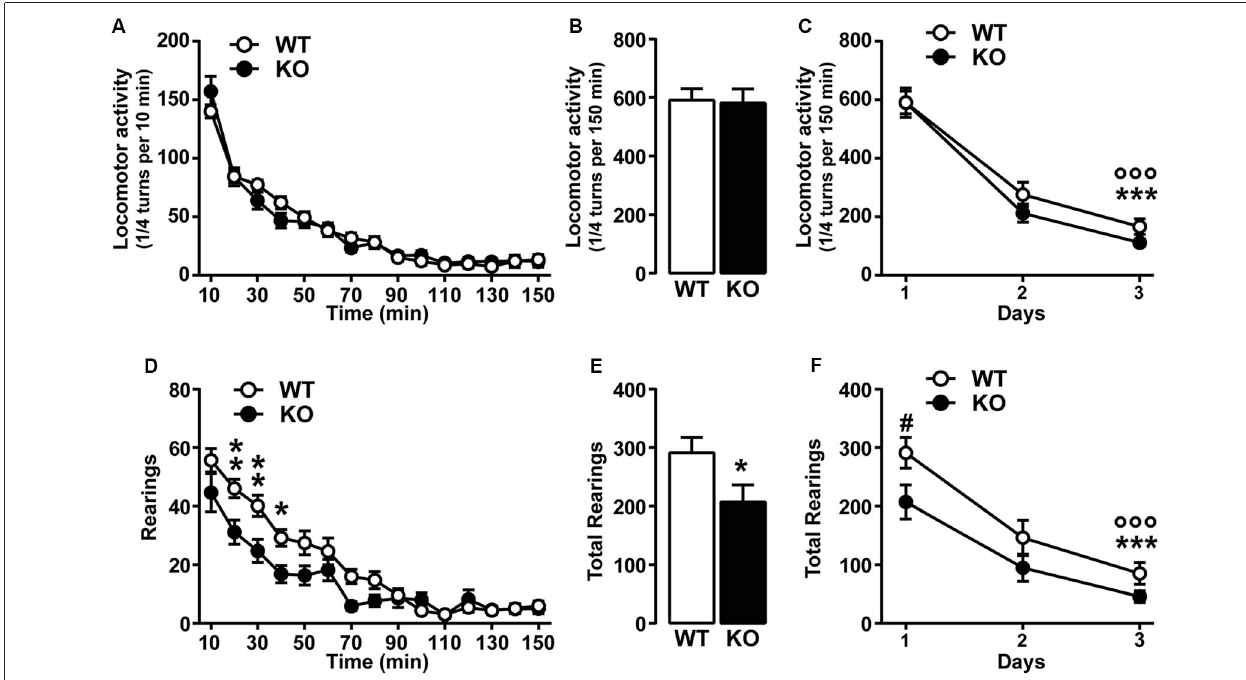
(vertical locomotor activity) of Ca v 3.2 null mice ( n = 22) and their WT littermates ( n = 26) in a novel non-stressful environment. Data (means ± SEM) were analyzed using two-way ANOVA: (Time × Genotype: F ( 14,644 ) = 3.751, P < 0.0001; Time: F ( 14,644 ) = 70.86, P < 0.0001; Genotype: F ( 1,46 ) = 4.601, P = 0.0373). Specific comparisons: ** p < 0.01 and * p < 0.05 (KO vs. WT). (E) Cumulative rearing activity of WT and Ca v 3.2 KO mice over a 150 min period. Data (means ± SEM) were analyzed using Student’s t -test: * p < 0.05. (F) Environmental habituation over a period of 3 days measured as a reduction of spontaneous rearing activity. Data (means ± SEM) were analyzed using two-way ANOVA: (Time × Genotype: F ( 2,92 ) = 1.139, P = 0.3246; Time: F ( 2,92 ) = 76.78, P < 0.0001; Genotype: F ( 1,46 ) = 3.874, P = 0.05). Specific comparisons: *** p < 0.001 (WT-Day3 vs. WT-Day1), ◦◦◦ p < 0.001 (KO-Day3 vs. KO-Day1) and # p < 0.05 (KO-Day1 vs.